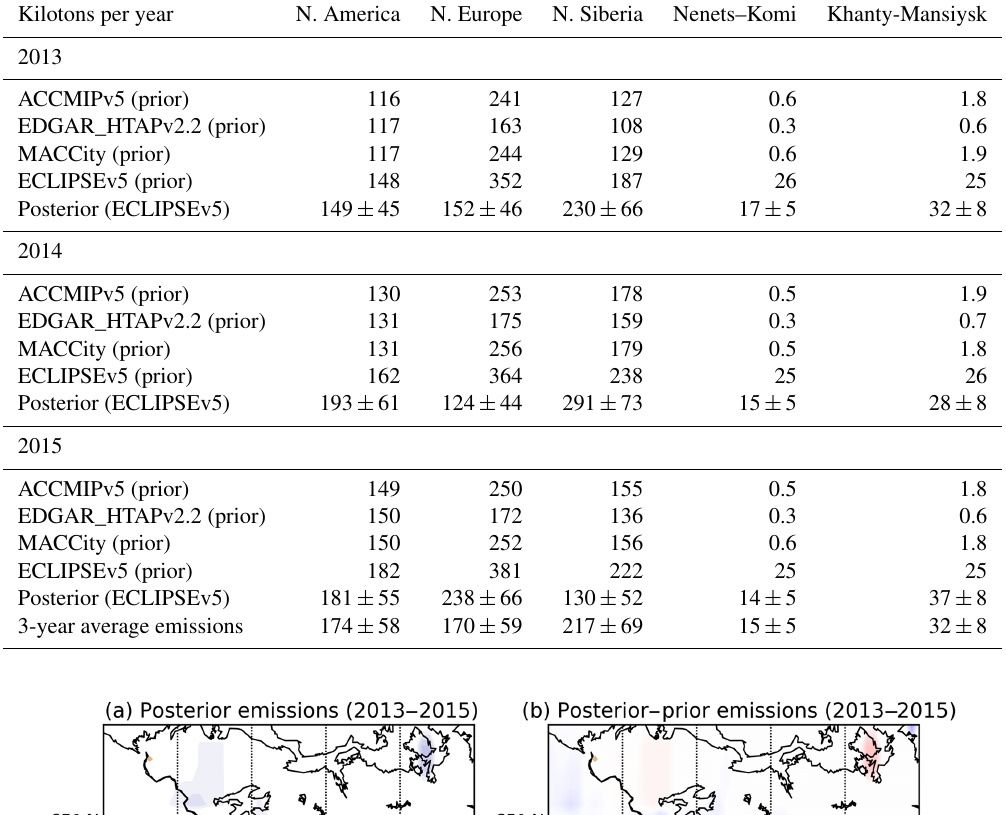
Table 3. Annual prior (ACCMIPv5, EDGAR_HTAPv2.2, MACCity and ECLIPSEv5) and posterior emissions of BC for 2013, 2014 and 2015 (inversion using best representative species and best prior inventory).